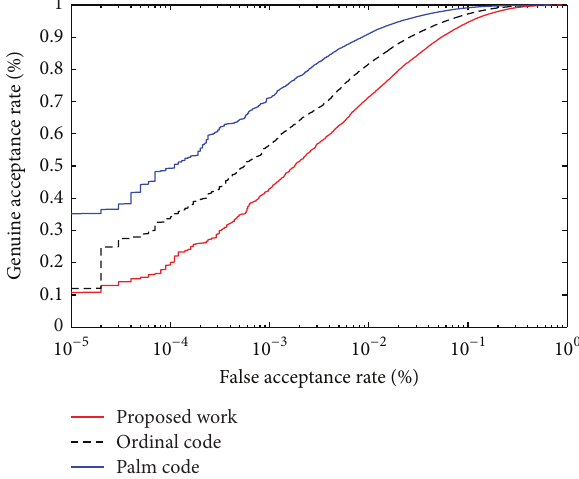
Figure 16: ROC curve using global features of proposed DOST for IIT Delhi palmprint database.